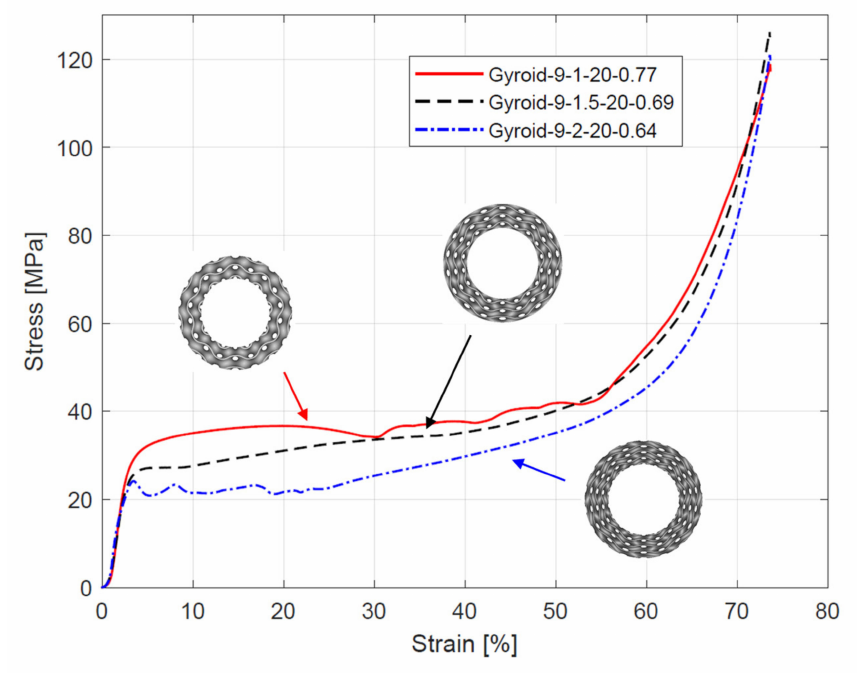
Figure 8. Stress–strain curves from compressive testing of cylindrically mapped gyroid structures with 9 unit cells in a circumferential